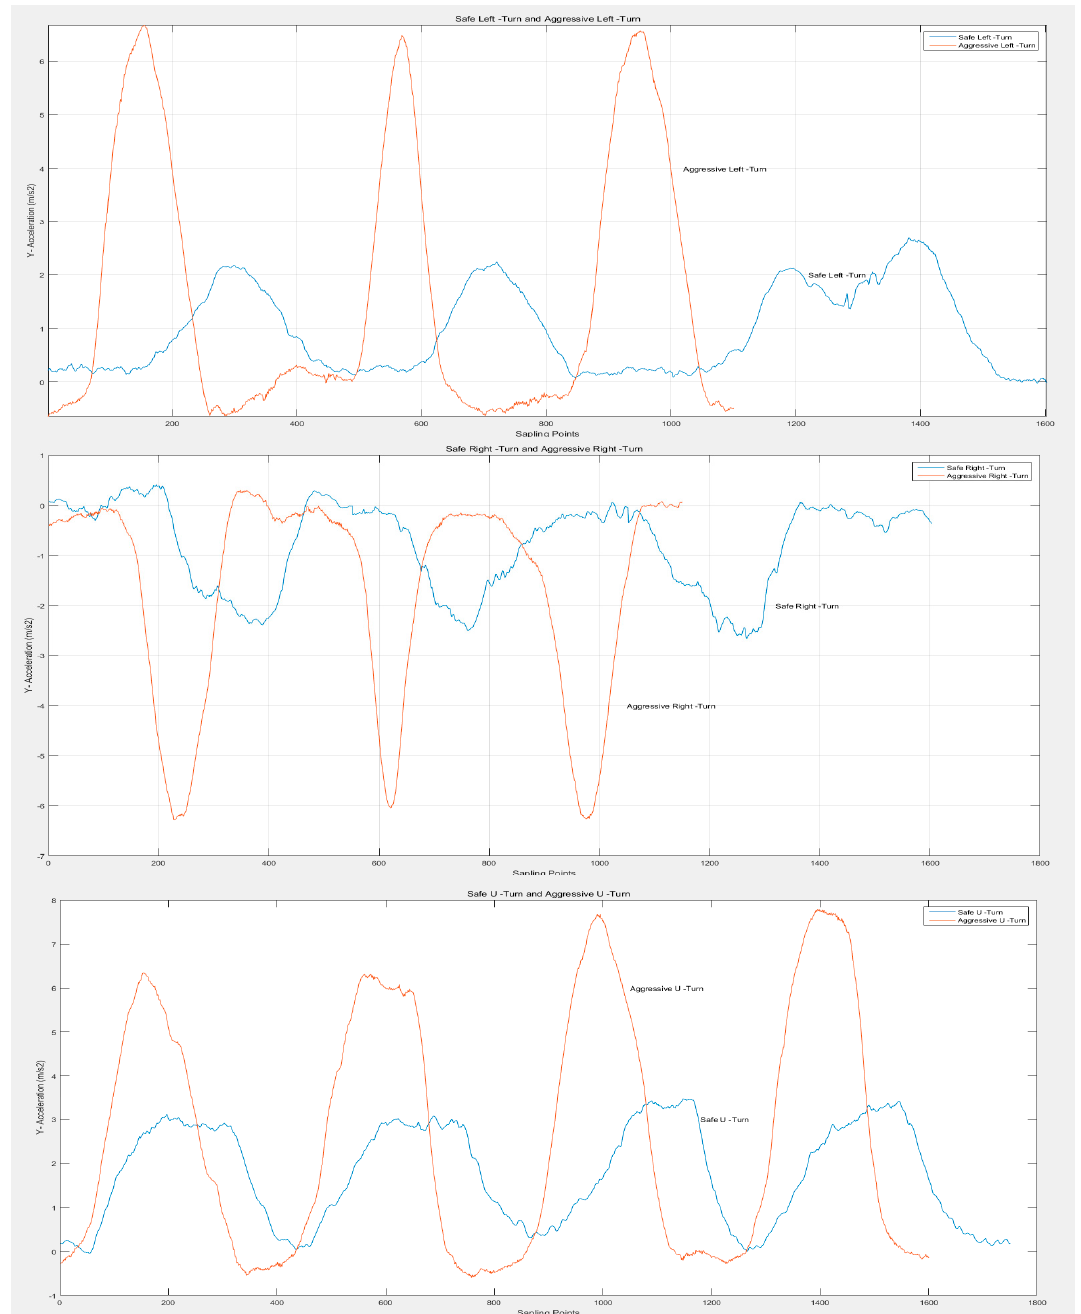
Figure 8. Data comparison of Y -axis acceleration between normal and aggressive LT, RT and UT.